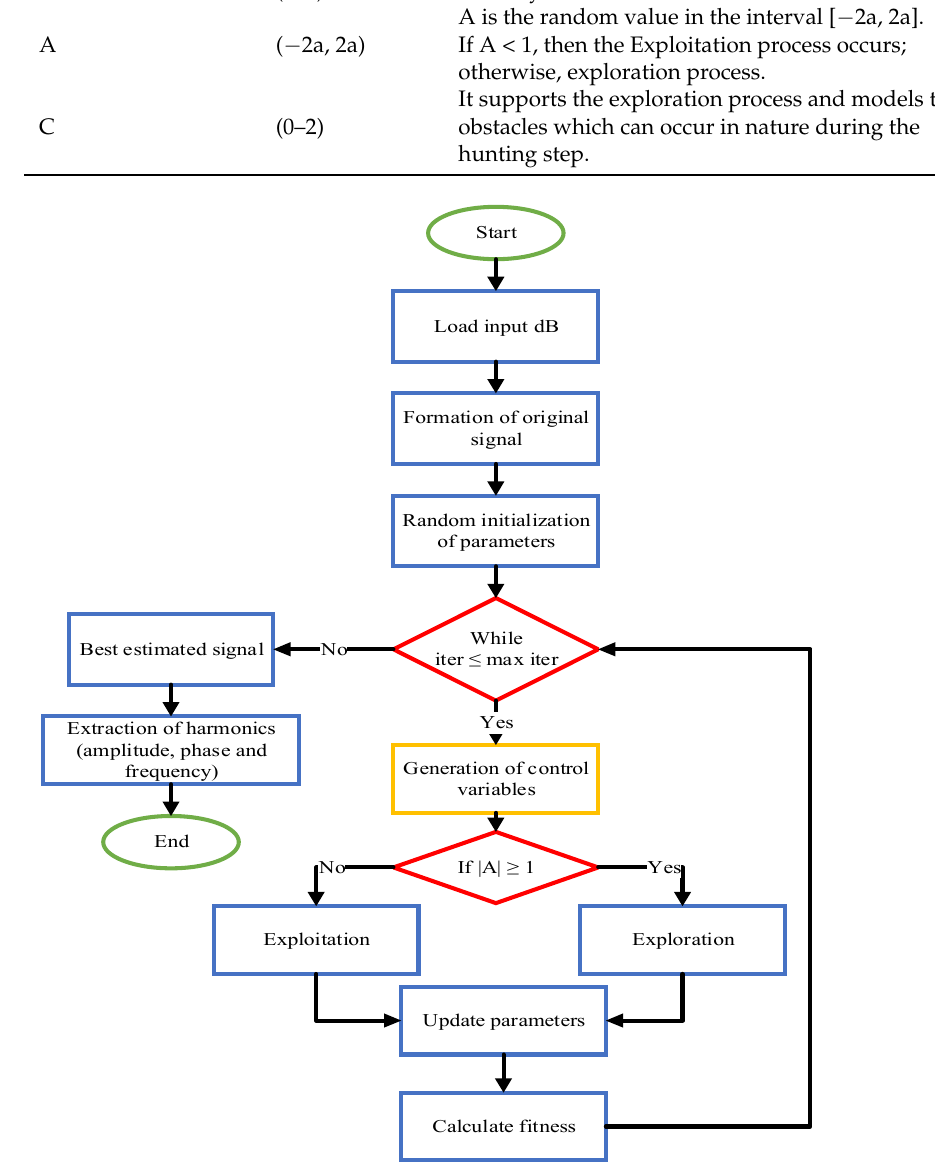
Figure 4. Flowchart of GWO-LS Harmonic